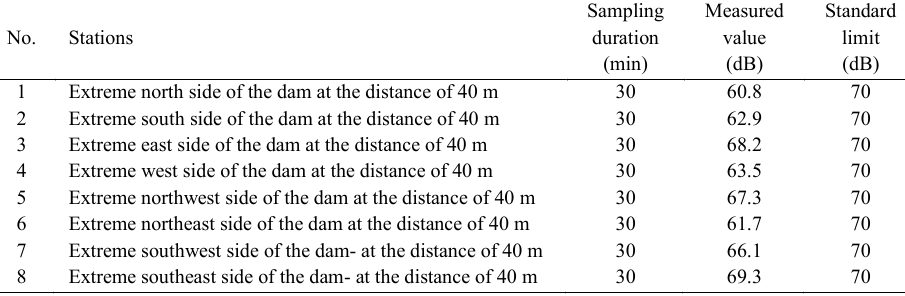
Table 8: Noise assessment at the site of Gavi Dam